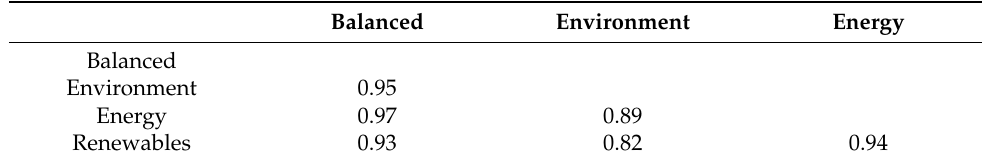
Table 7. Correlation coefficients for